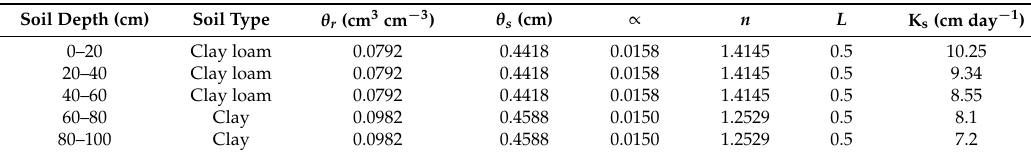
Table 4. Optimized values of soil hydraulic parameters.